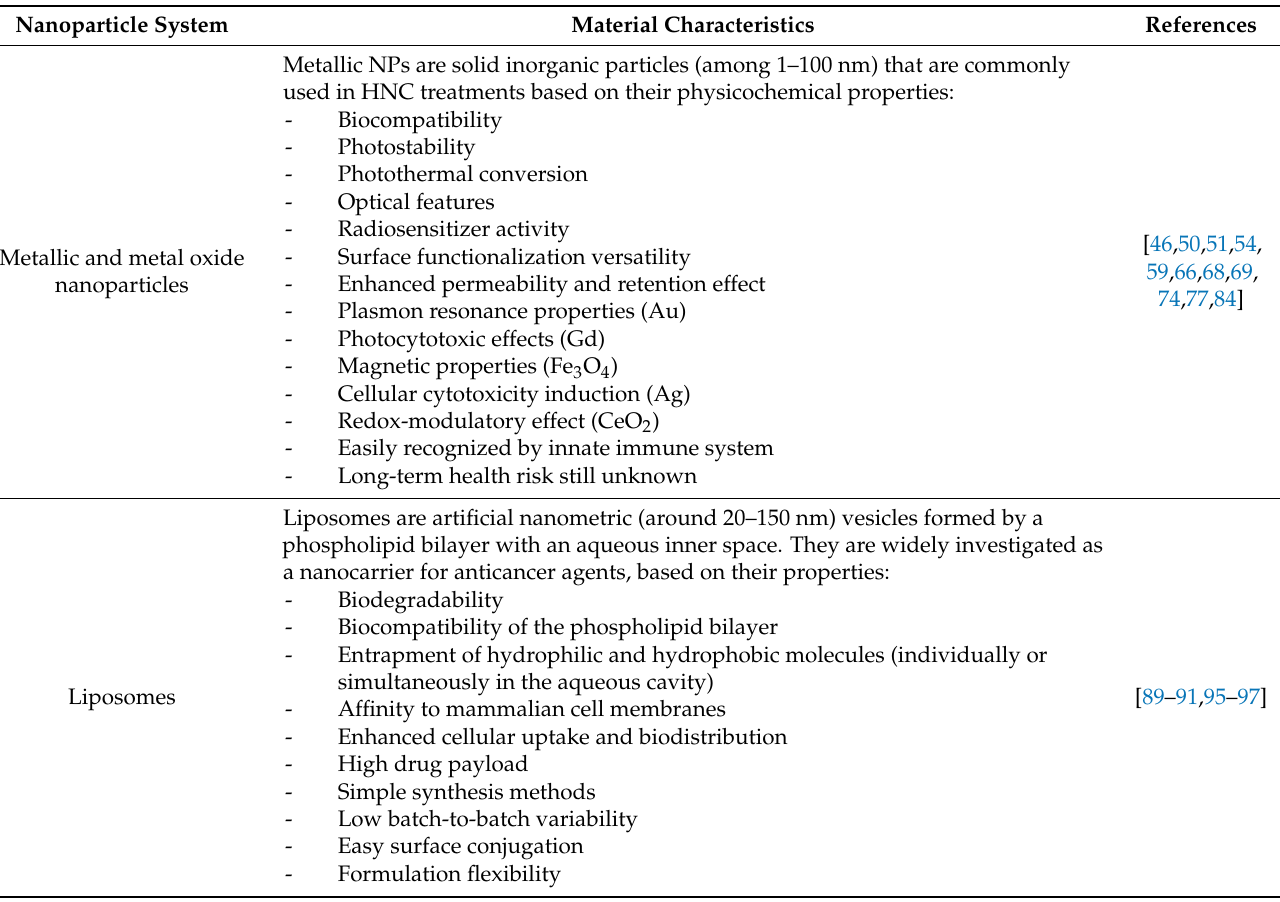
Table 1. Comparison between the properties of the nanoparticle systems most used for the treatment of head and neck cancer. Nanoparticle System Material Characteristics